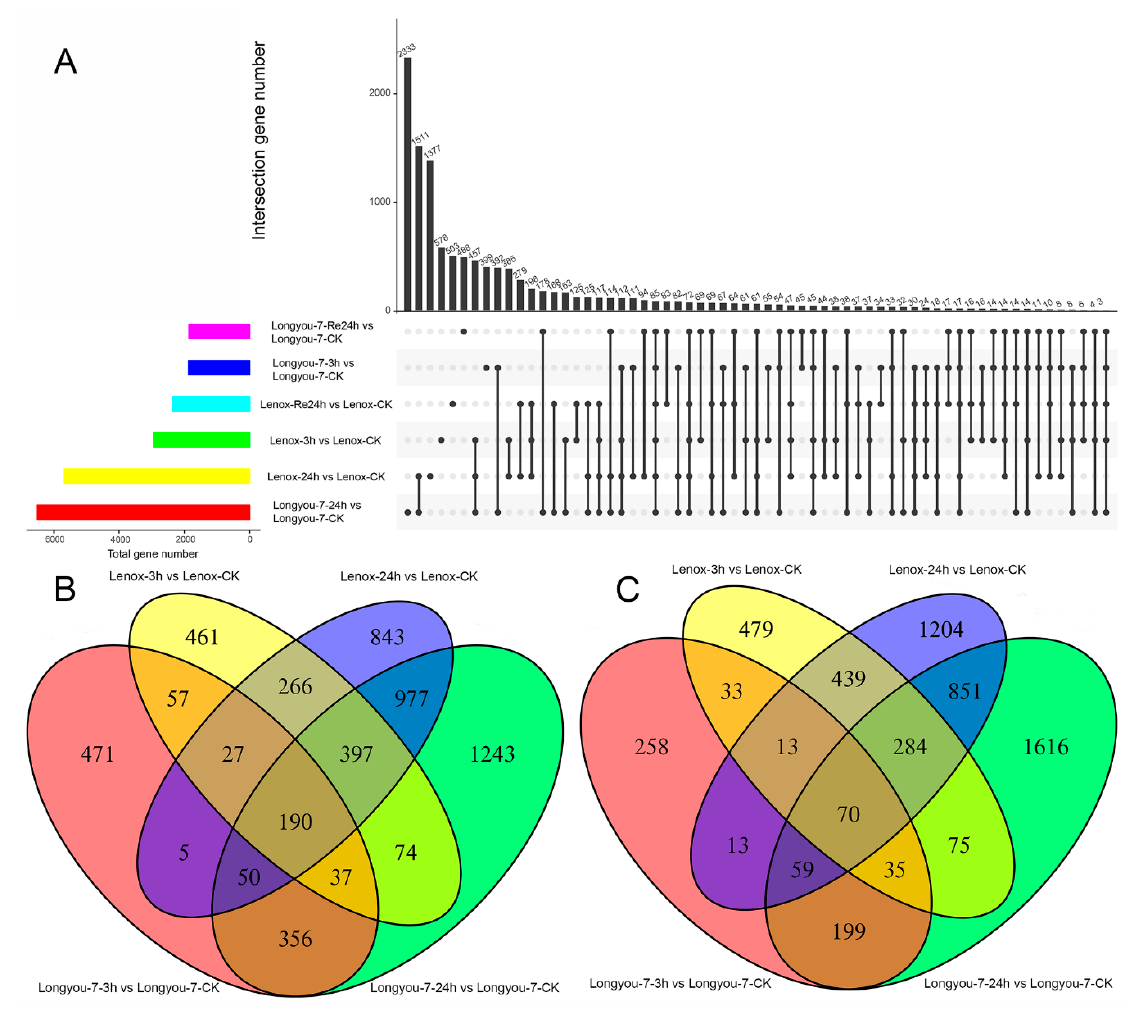
Figure 2. DEGs identified for three treatments in Longyou-7 and Lenox. ( A ) All DEGs for the three treatments. The bar charts indicate DEGs under single treatment (the x axis represents the number of genes); column charts indicate DEGs under single or multiple processes (in the x -axis, black dots represent a single treatment, black lines connected by dots represent multiple treatments, and the y -axis represents the number of genes corresponding to them). ( B ) Upregulated DEGs identified with cold treatment at 4 °C for 3 and 24 h in Longyou-7 and Lenox; ( C ) downregulated DEGs identified with cold treatment at 4 °C for 3 and 24 h in Longyou-7 and Lenox.